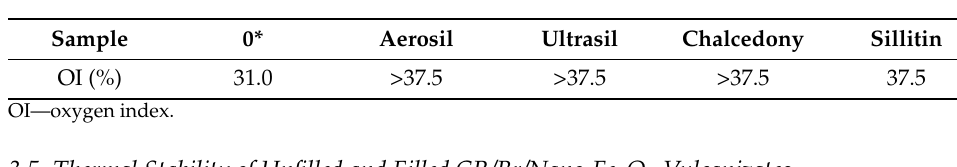
Table 9. Flammability of unfilled and filled CR/BR/nano-Fe 2 O 3